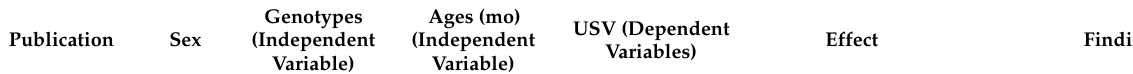
Table 4. Summary of interaction effects and main effects of genotype and age on USV production between Pink1-/- rats and WT